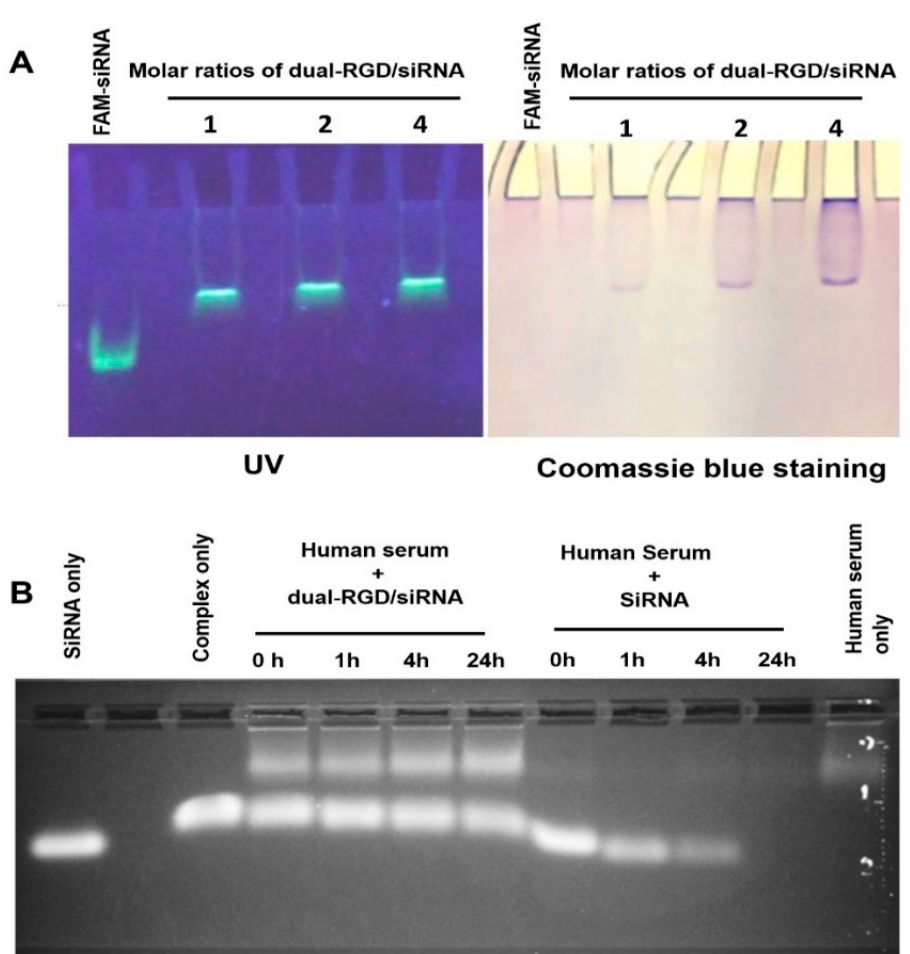
Figure 2. Characterization of dual-RGD on binding and protection of siRNA. ( A ) Gel retardation to assess dual-RGD/siRNA binding. FAM-labeled siRNA was incubated with different molar ratios of dual-RGD protein. The complexes were detected by 1% agarose electrophoresis. SiRNA migration location was imaged under a UV transilluminator. To localize dual-RGD protein position, the same gels were stained with Coomassie blue. Two images show that dual-RGD and siRNA were at the same location, indicating dual-RGD binding to siRNA. ( B ) Protection of siRNA against nucleases. Naked siRNA or siRNA/dual-RGD complexes were incubated with 50% ( v / v ) human serum for different time periods at 37 °C. The siRNA degradation was probed using agarose gel electrophoresis.